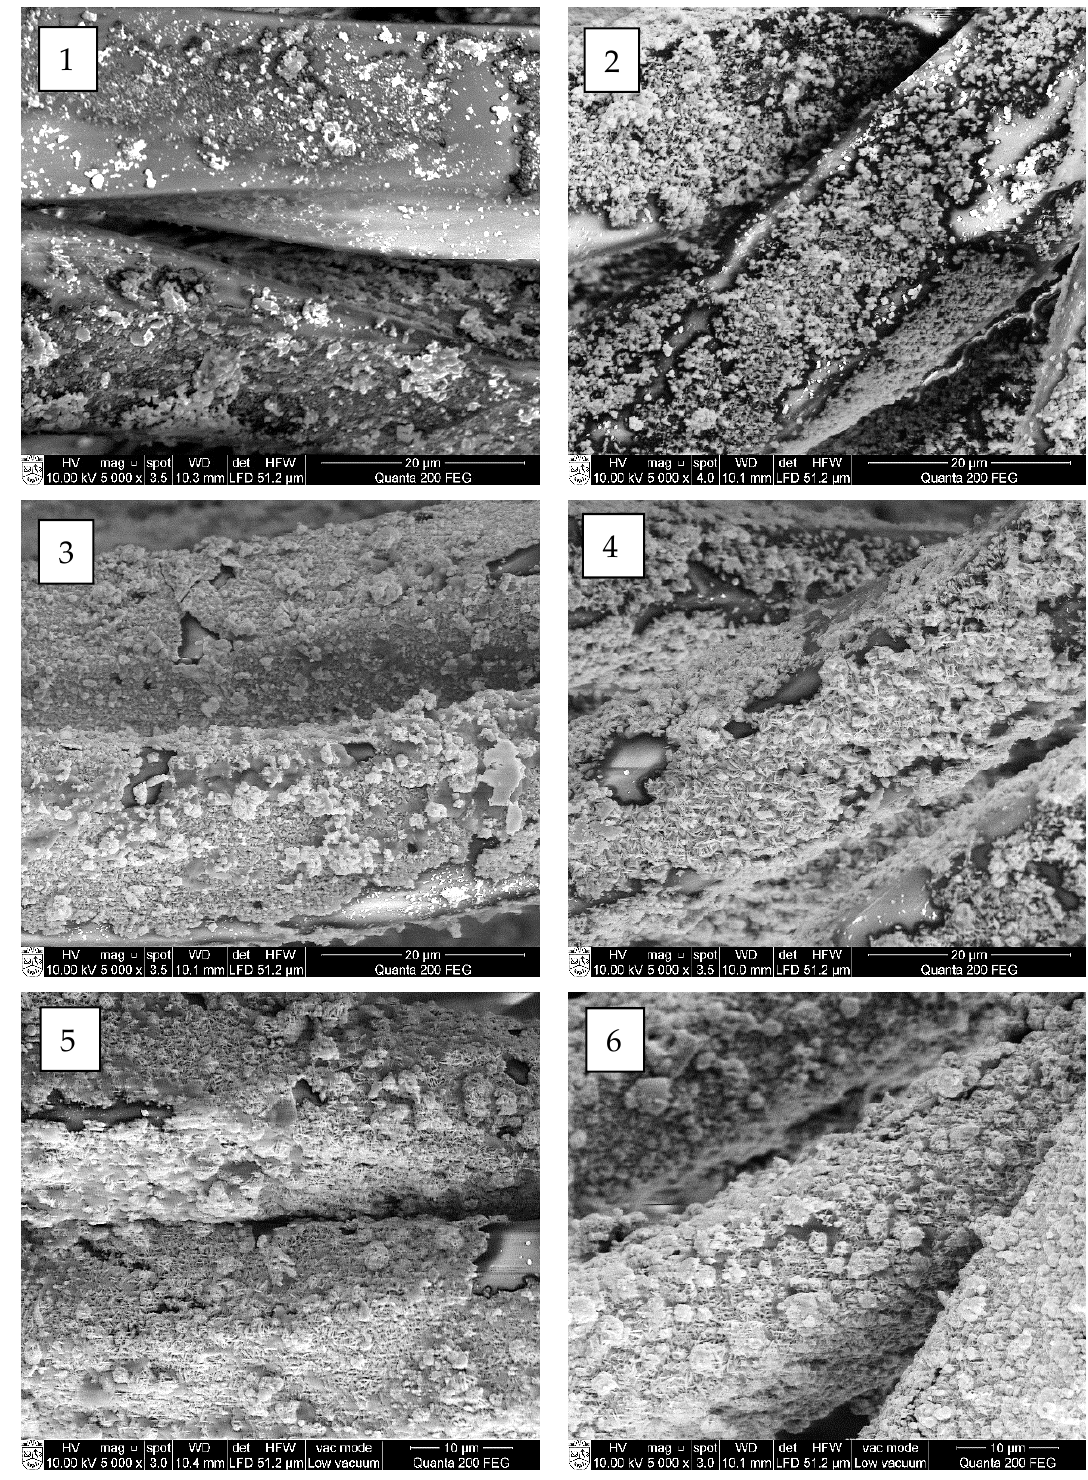
Figure 9. SEM images of copper selenide-coated PA66 fibers after different numbers of treatment cycles: ( 1 ) first (mag. 5000×); ( 2 ) second (mag. 5000×); ( 3 ) third (mag. 5000×); ( 4 ) fourth (mag. 5000×); ( 5 ) fifth (mag. 5000×); and ( 6 ) sixth (mag. 5000×).